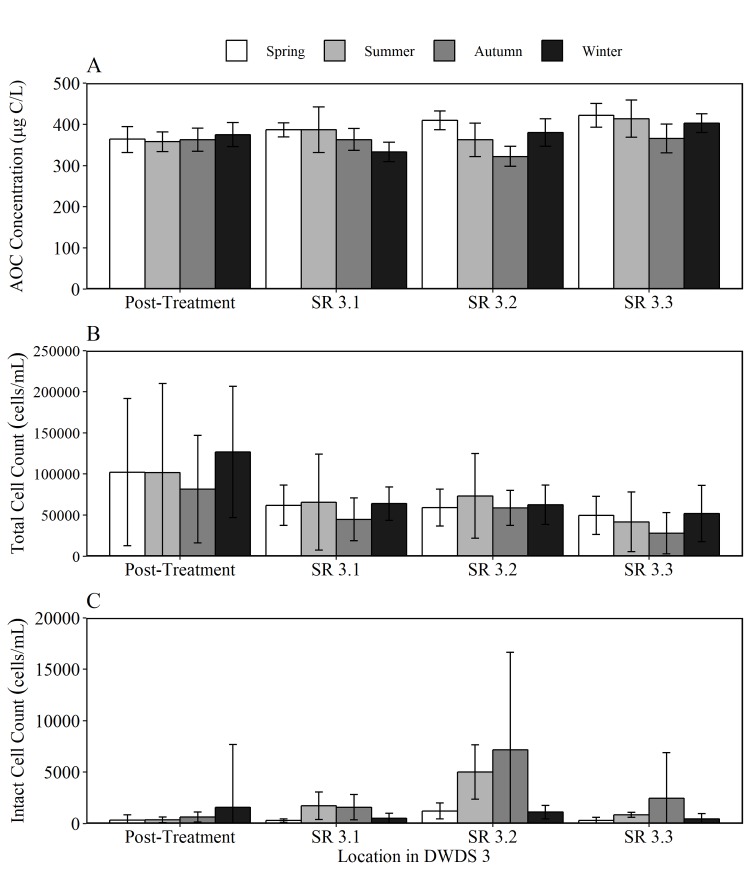
Seasonal water quality data for DWDS 3.Variation in the mean a) AOC concentration b) total cell counts (TCC) and c) intact cell counts (ICC) in post-treated water and three service reservoirs within the DWDS. Nb different y-axis scale for each parameter, and different y axis scales used in Fig 9, Fig 10 and Fig 11. Data was split into spring, summer, autumn and winter seasons based on monthly averages in temperature.